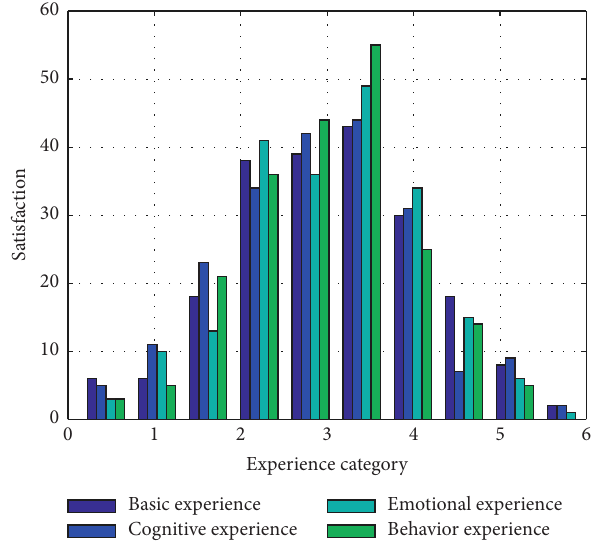
Figure 12: Histogram of user experience category